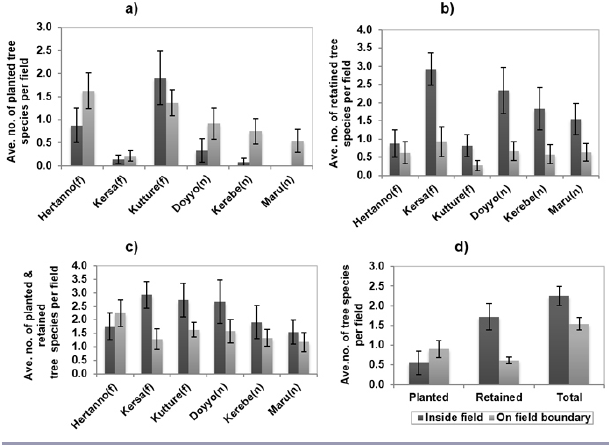
Fig. 2 . Average numbers of tree species, recorded inside and along boundaries of annual crop fields that were: (a) planted, (b) retained, (c) planted and retained pooled for individual villages, and (d) pooled data from all villages. The statistical interpretations of the patterns are found in the text. Error bars are standard error. The sample size is found in Table 2.